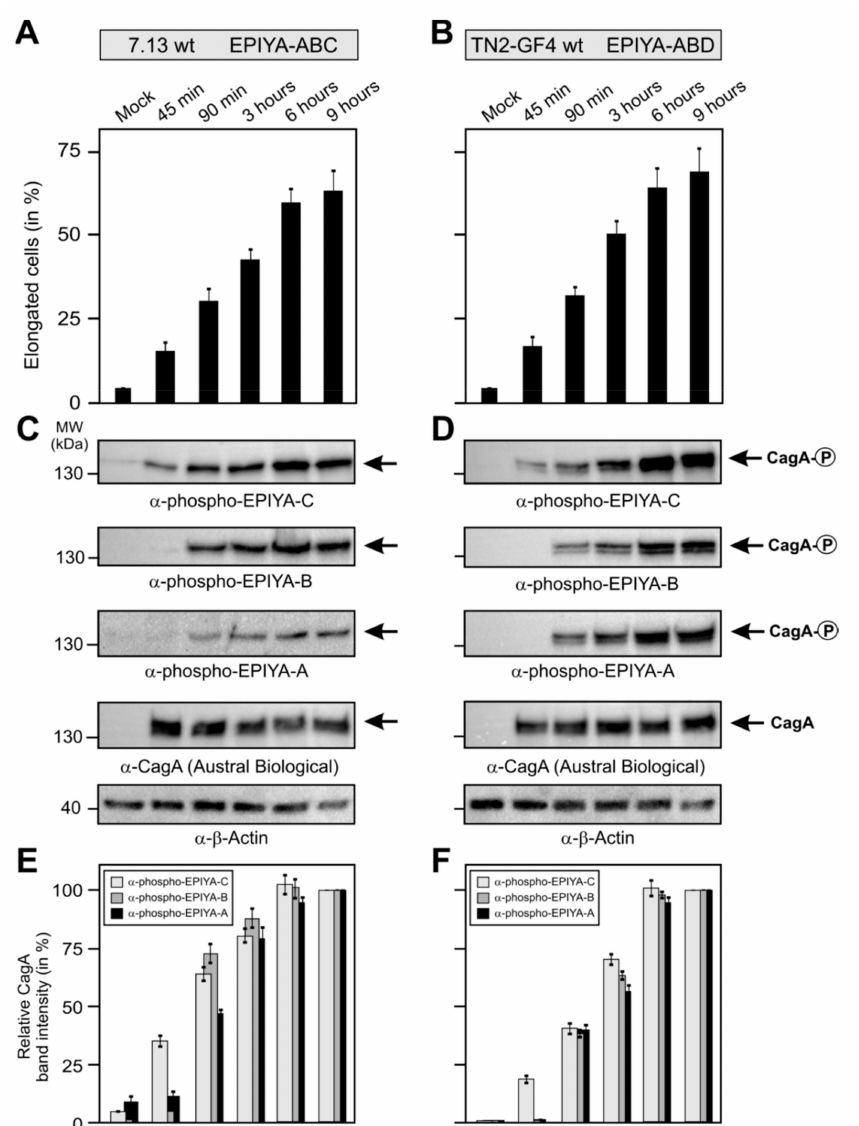
Figure 6. Time-dependent phosphorylation patterns of EPIYA-motifs in H. pylori strains during infection of AGS cells. The ABC-type CagA H. pylori strain 7.13 ( A ) and ABD-type CagA H. pylori strain TN2-GF4 ( B ) were used to infect AGS cells for the indicated times. Quantification of elongated cells was performed in triplicate. Mean values are shown with standard error. ( C , D ) Western blotting was performed using the three indicated α -phospho EPIYA antibodies with α -CagA and α - β -Actin as loading controls. ( E , F ) Quantification of phospho-CagA band intensities in the above blots was performed in triplicate by densitometry. Mean values are shown with standard